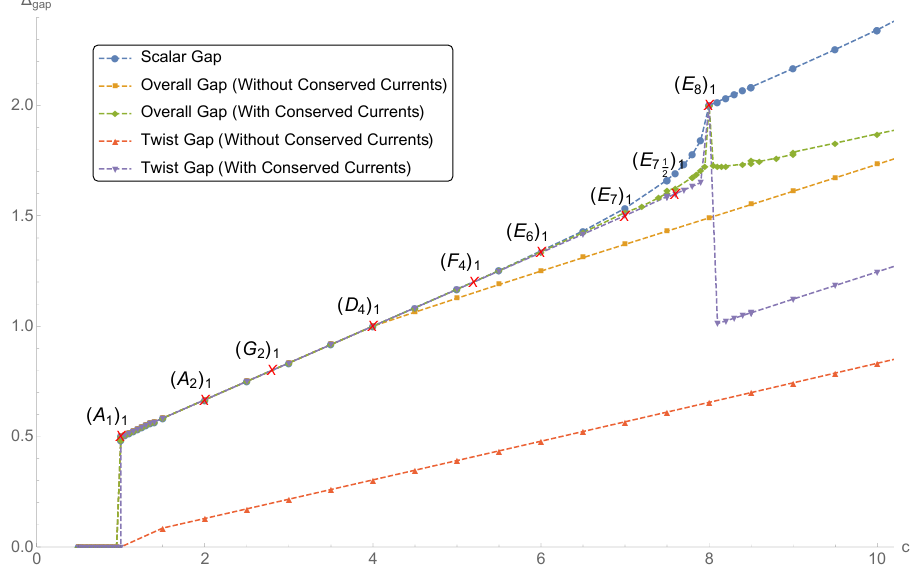
Figure 16. Numerical upper bounds on the scalar gap, overall gap and twist gap with W ( F 4 ) = W (2 ; 6 ; 8 ; 12) algebra in the range of 1 (cid:20) c (cid:20) 10.